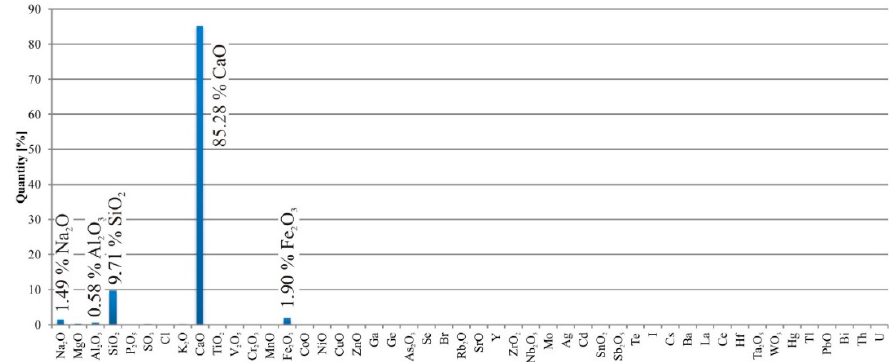
Figure 8. Material analysis of the crystals from the cube test specimens.